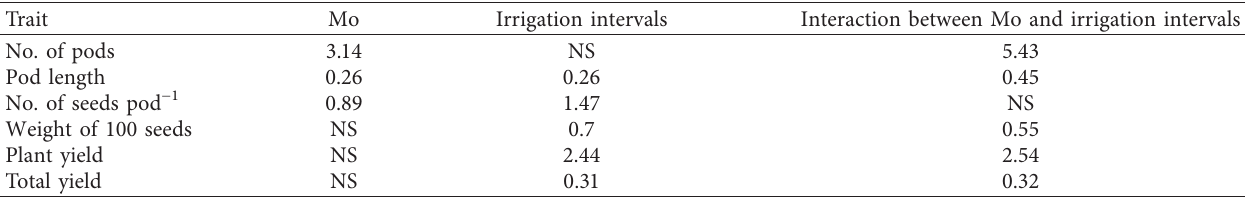
Figure 2: The effect of molybdenum treatment on the yield components: (a) number of pods, p � 0 . 002,(b) length of pods (cm), p � 0 . 02, (c) number of seeds per pod, p � 0 . 01, (d) weight of 100 seeds (g) p � 0 . 04, (e) plant yield (g plant − 1 ), p ≥ 0 . 001 of mung bean, and (f) total yield (ton ha − 1 ) p � 0 . 04. Table 2: Least significant differences (LSD) of the impact of molybdenum (Mo), irrigation (I), and the interaction between Mo and I treatments on the yield traits; number of pods, pod length, number of seeds/pod, weight of 100 seeds, plant yield, and total yield of mung beans.